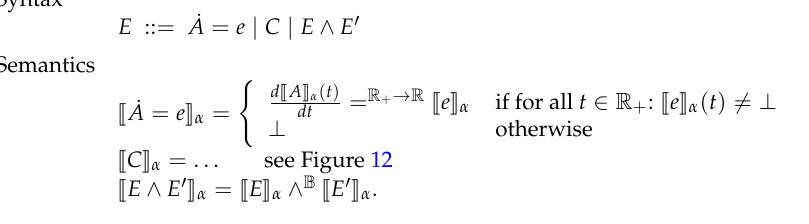
Figure 14. System of constrained equations of a constrained flux network V & C